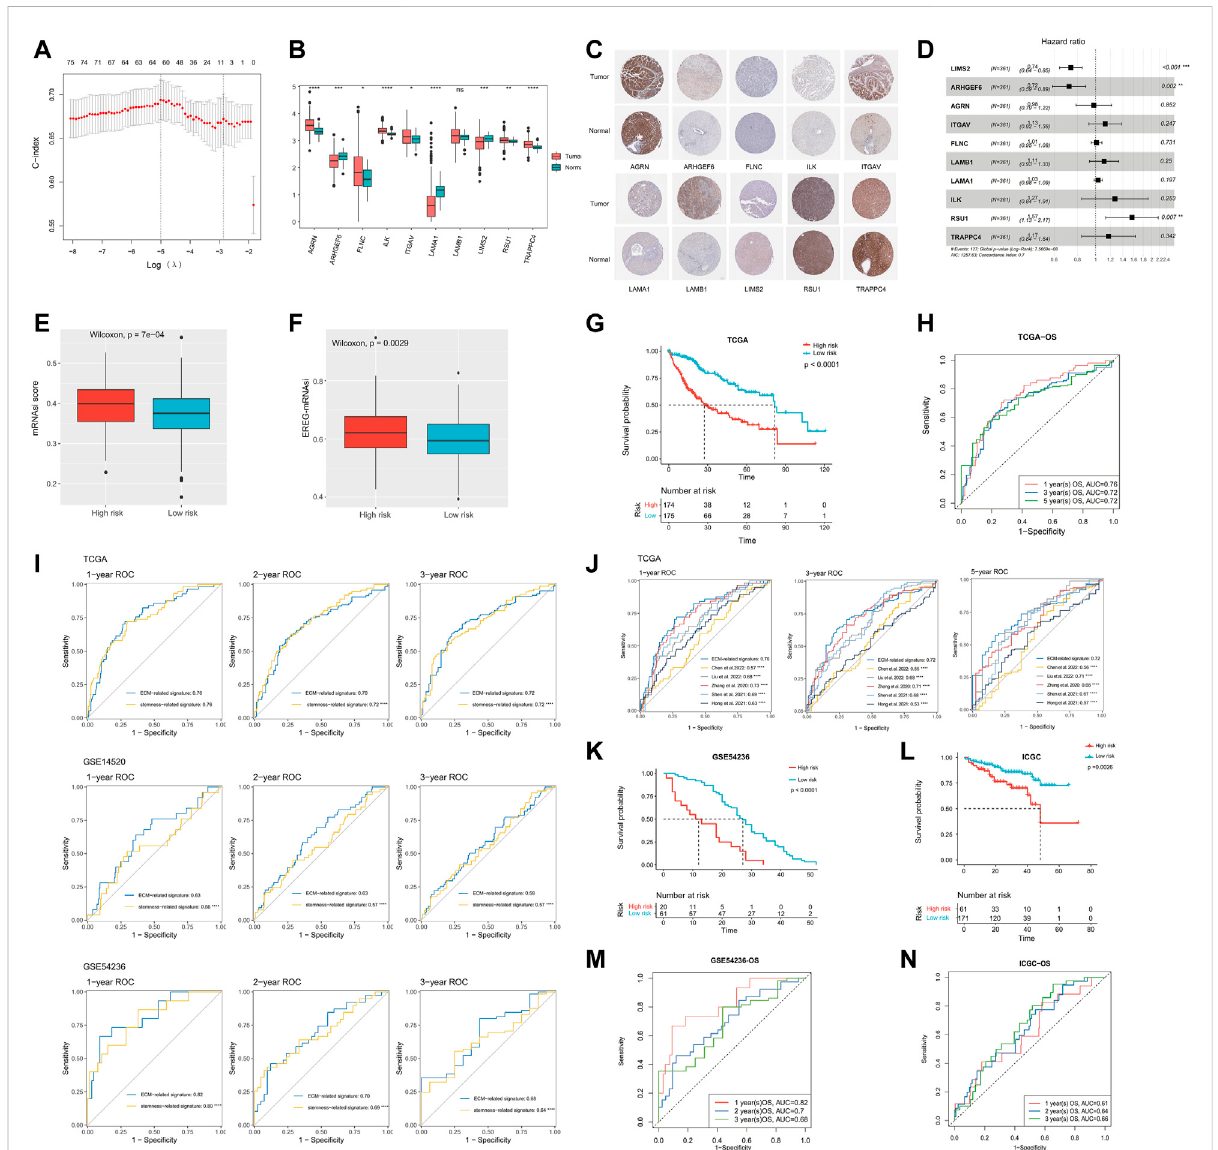
FIGURE 2 Construction and validation of the ECM-related prognostic model. (A) LASSO regression analysis showed the partial likelihood deviation curve oftheminimumnumbergenescorrespondingtothecovariates(theabscissarepresentstheCI ofeachlambda, andtheordinate representserrorsin cross-validation). (B) Expression analysis of the 10 genes ( TRAPPC4 , RSU1 , ILK , LAMA1 , LAMB1 , FLNC , ITGAV , AGRN , ARHGEF6 , and LIMS2 ) in HCC samples and normal samples. (C) Representative immunohistochemical staining plots for 10 selected genes. (D) Univariate Cox regression analysis of these 10 genes. (E) Comparison of mRNAsi scores between high- and low-risk groups. (F) Comparison of EREG-mRNAsi scores between high- and low-risk groups. (G) Kaplan – Meier curves showing different overall survival of patients in high- and low-risk groups. (H) ROC curves of ECM-related signature for predicting the 1/3/5-year overall survival in TCGA. (I) Performance comparison of ECM-related signature and stemness- relatedsignature(constructedbasedontheDEGsbetweenthemRNAsi-highandmRNAsi-lowgroups). (J) PerformancecomparisonofECM-related signature and published stemness-related signatures. (K) Kaplan – Meier curves showing different overall survival of patients in high- and low-risk groups based on GSE54236. (L) Kaplan – Meier curves showing different overall survival of patients in high- and low-risk groups based on ICGC. (M) ROC curves of ECM-related signature for predicting the 1/2/3-year overall survival in GSE54236. (N) ROC curves of ECM-related signature for predicting the 1/2/3-year overall survival in ICGC. LASSO, least absolute shrinkage and selection operator; mRNAsi, mRNA expression – based stemness index; ROC, receiver operating characteristic; ECM, extracellular matrix; TCGA, The Cancer Genome Atlas; IGGC, International Cancer Genome Consortium; DEG, Differentially Expressed